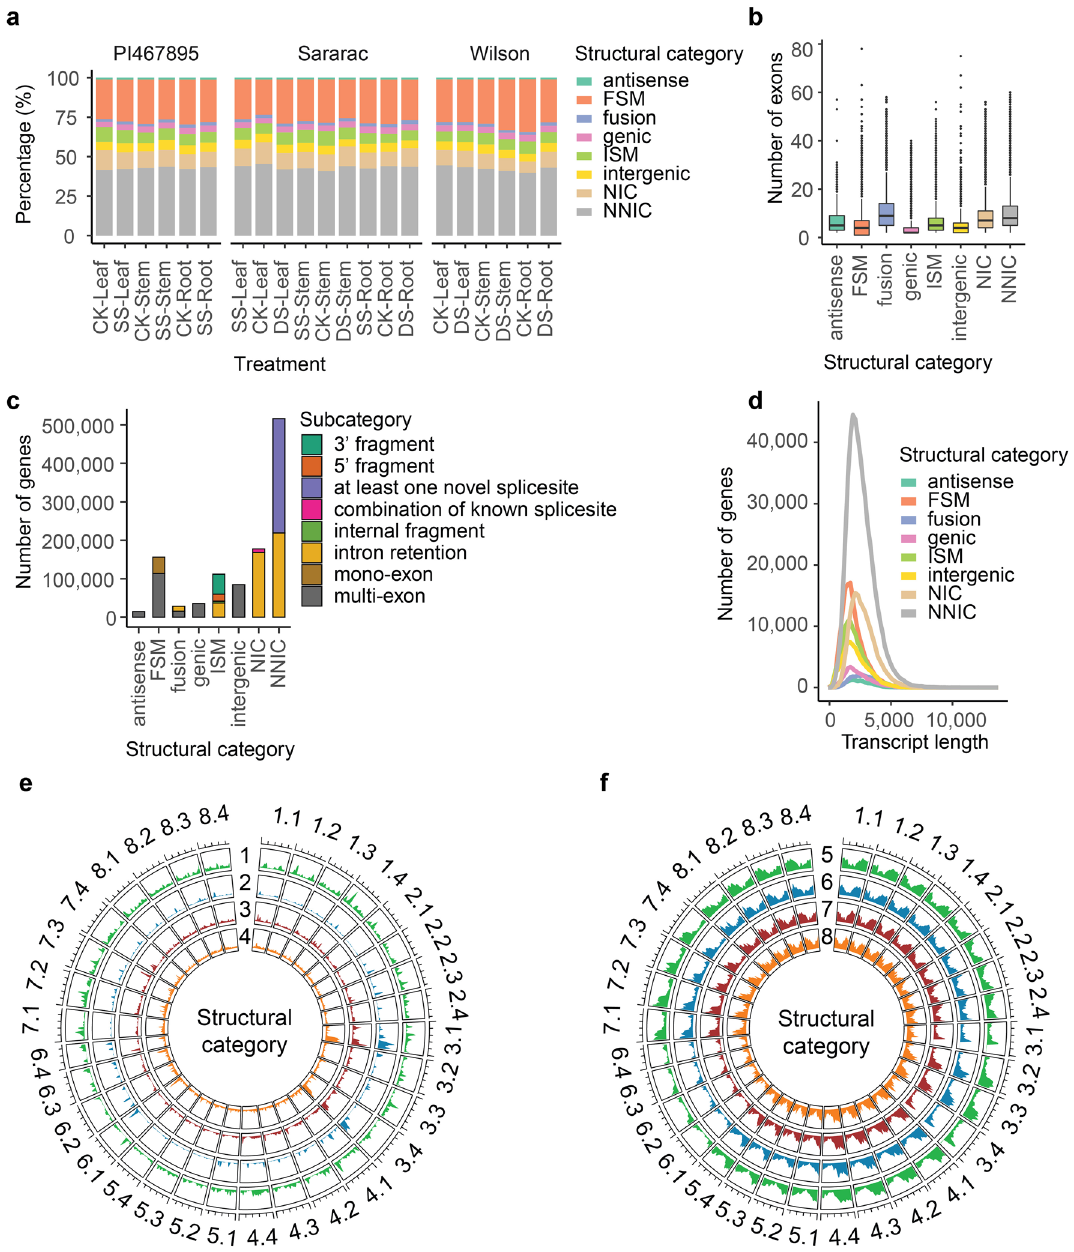
Figure 3. Structural categories of transcriptome classified by SQANTI3. ( a ) Percentage of structural category classification in 21 transcriptomes: germplasms PI467895, Saranac and Wilson in three tissue sources; leaf, stem and root; under salt stress (SS), drought stress (DS) or control non-stressed treatments (CK). ( b ) Boxplot of structural category classification by exon number. ( c ) Structural category frequency by transcript length in base pairs. ( d ) Gene count classified by structural category and subcategory classification. ( e ) Structural category distribution along Medicago sativa chromosomes for (1) fusion, (2) antisense, (3) genic, and (4) intergenic transcripts. ( f ) Structural category distribution along M. sativa chromosomes for (5) FSM, (6) ISM, (7) NIC and (8) NNIC transcripts. Structural category in SQANTI3 classified transcripts in antisense, full-splice match (FSM), fusion, genic, incomplete-splice match (ISM), intergenic, novel in catalog (NIC) or novel not in catalog (NNIC)